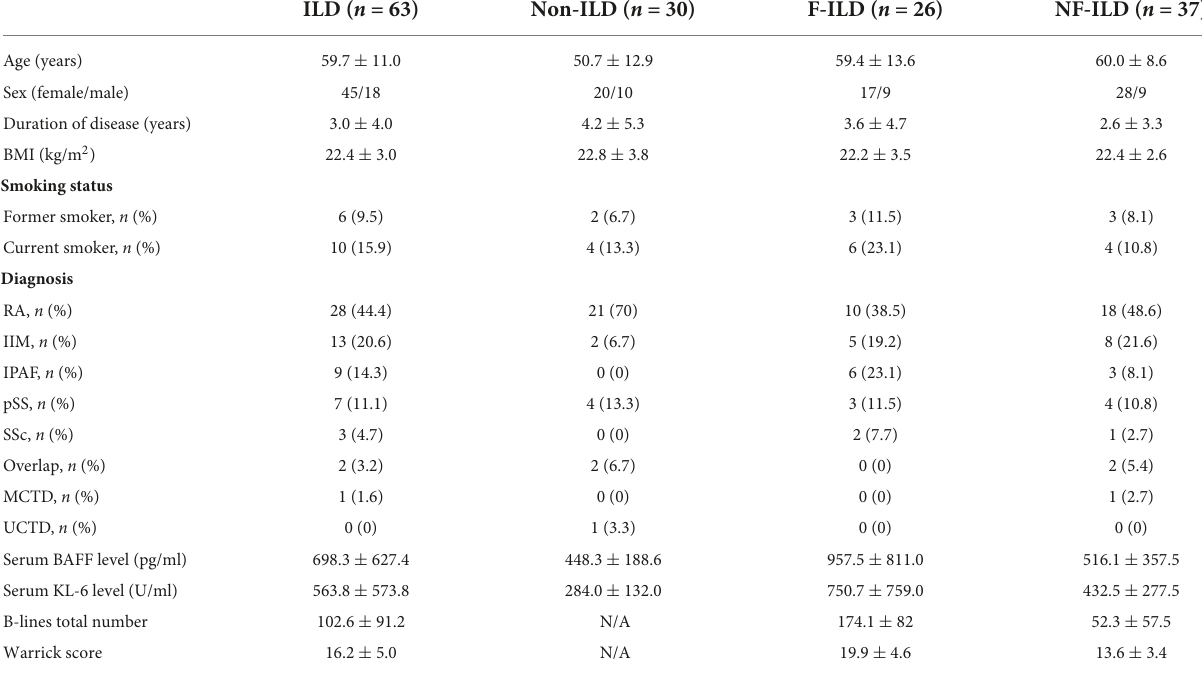
TABLE 1 CTD Patients’ demographic and clinical features.